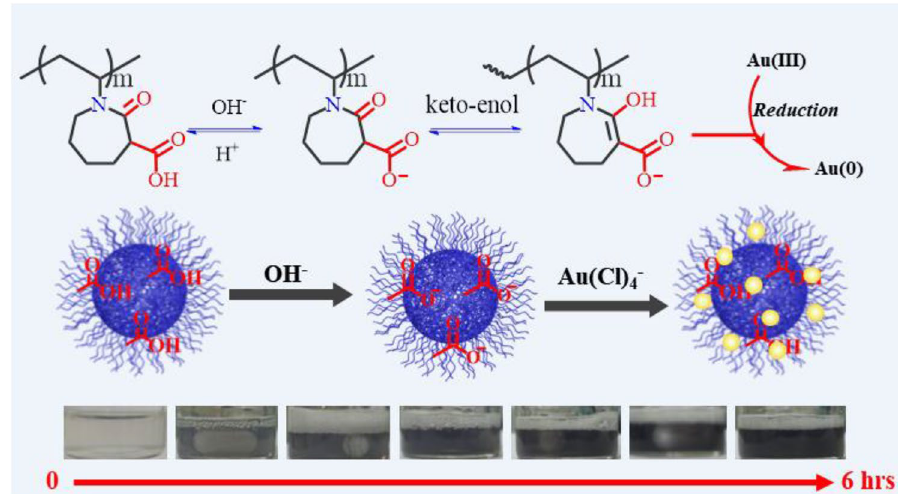
Fig. 1 Schematic diagram of the in situ reduction of Au nanoparticles in the presence of PTBVCL-d copolymer micro- gels and its color changes as the reduction time increased from 0 to 6